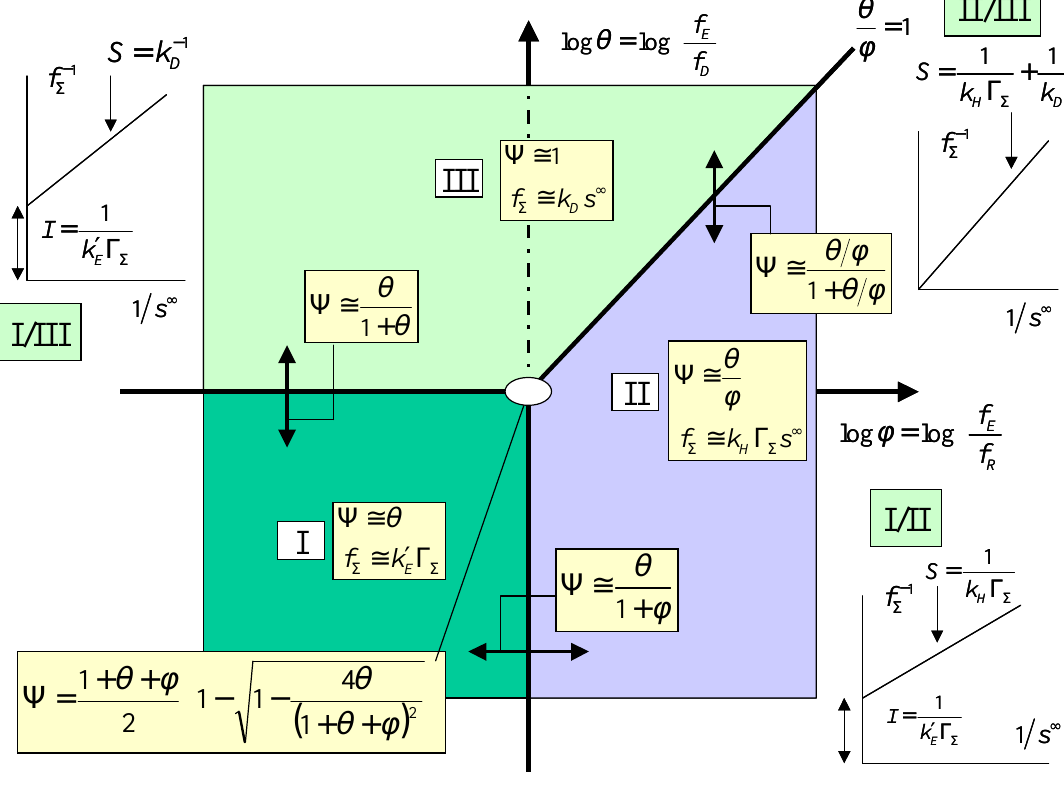
Figure 3. Kinetic case diagram for mediated electron transfer at a redox active